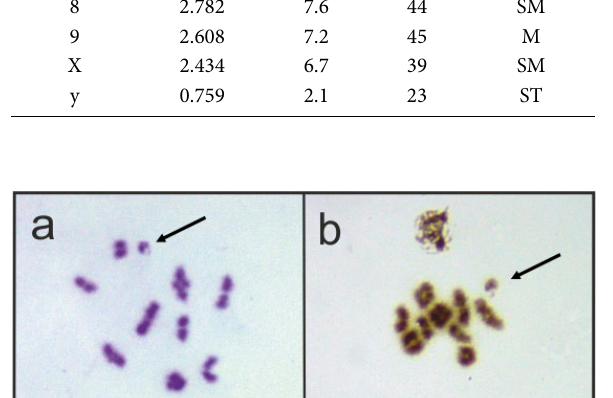
Fig. 1. (a) Oogonial metaphase (b) Spermatogonial metaphase of Accanthopus velikensis . Red and black arrows show X and minute y chromosomes respectively. Bars = 5μm.